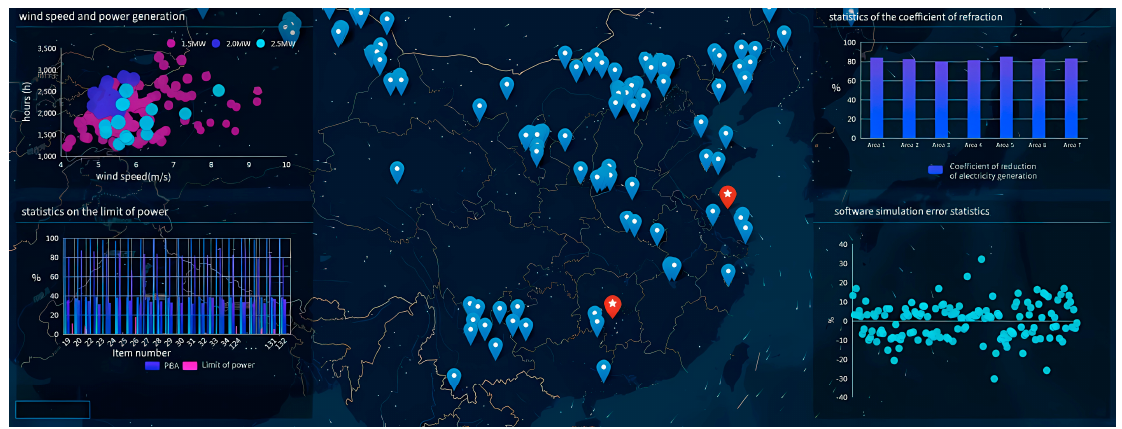
Figure 4. Project